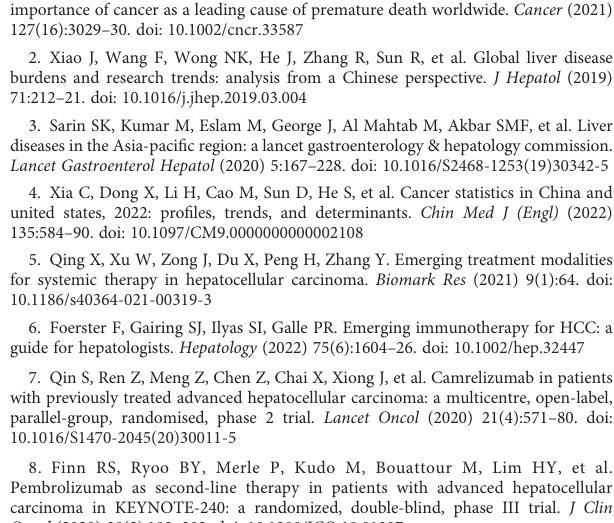
SUPPLEMENTARY FIGURE 1 Study design fl ow chart and validation process.